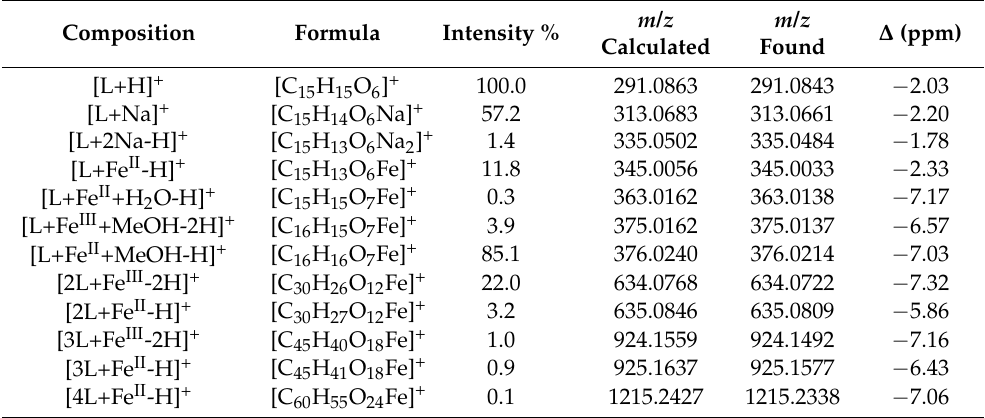
Table 2. The main signals of 56 Fe-catechin coordination complexes in the solutions of ( ± )-catechin with Fe III analyzed by nano-ESI–MS, positive ionization